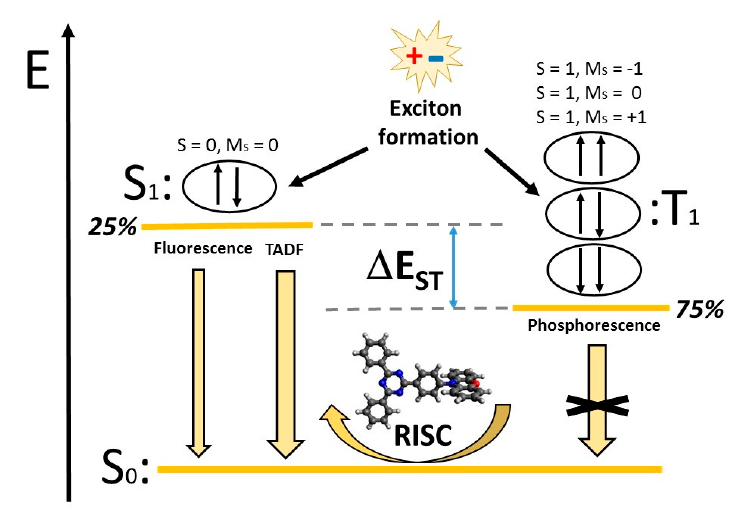
Figure 2. Sketch of the energy levels for the ground state (S 0 ) and lowest excited states (S 1 and T 1 ) of different multiplicity, involved in the thermally activated delayed fluorescence (TADF) mechanism after the exciton formation, and the corresponding reverse intersystem crossing mechanism (RISC) process from the T 1 to the S 1 states compared to fluorescence (emission from S 1 ) and phosphorescence (emission from T 1 ). Note the ideal energy up-conversion from the triply-degenerated T 1 to the S 1 state for sufficiently small Δ E ST values.